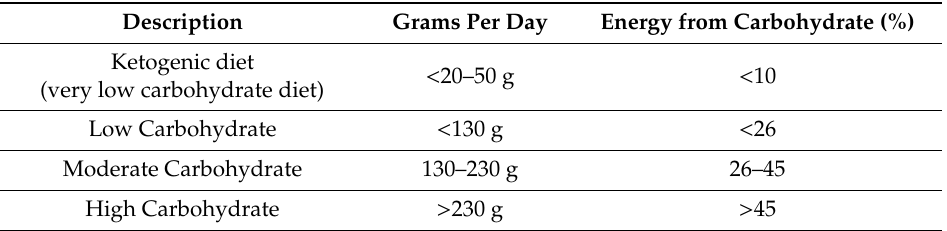
Table 1. Suggested definitions of di ff erent carbohydrate diets (Adapted from Feinman et al.)